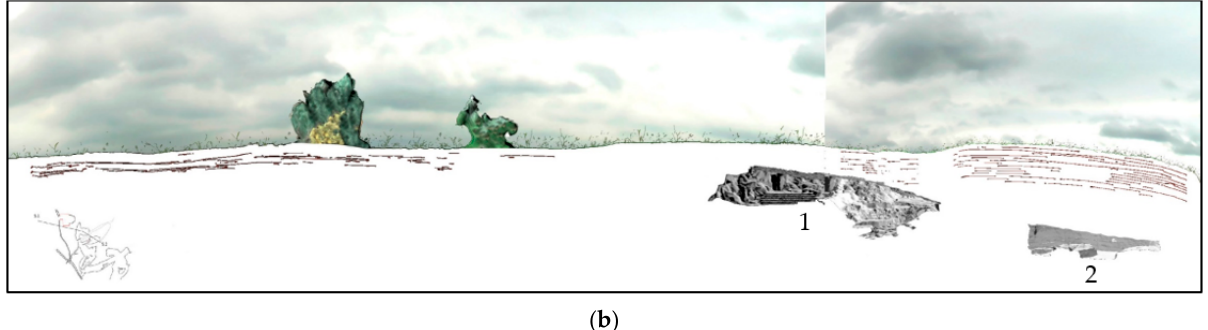
Figure 19. ( a ) Section of the integrated model in the Entrance Hall (1) and Polychrome Hall (2) area showing terrain, GPR (brown), and 3DTLS (grey) models. ( b ) Section with 6 m far plane of the integrated model in the Entrance Hall (1) and Polychrome Hall (2) area showing terrain, GPR (brown), and 3DTLS (grey) models.